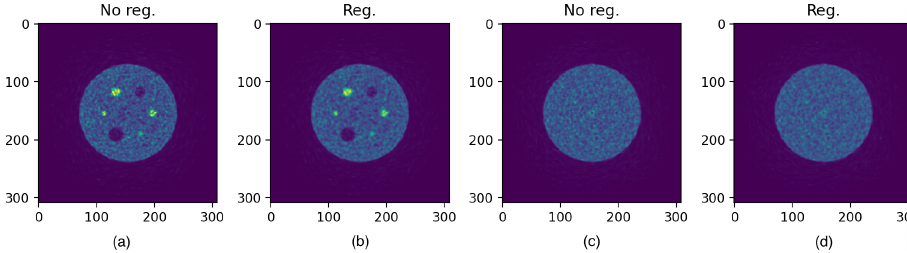
Figure 6. Reconstructed images at the 100th iteration. ( a , c ) are the non regularized images, while ( b , d ) are the regularized images.